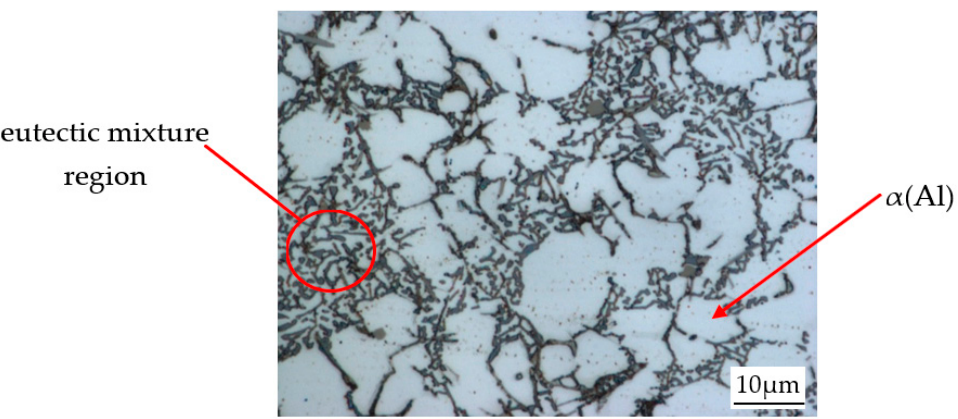
Figure 6. Microstructure of the high-pressure die casting (HPDC) EN AC-46000 base alloy: α (Al), eutectic region.